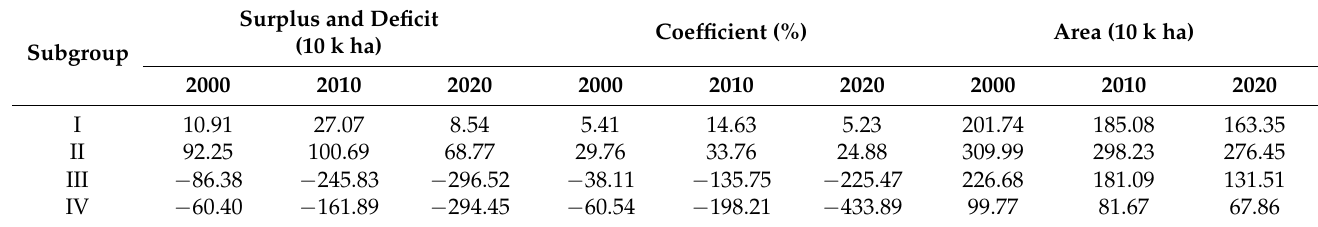
Table 4. Farmland surplus and deficit at urban subgroup scale.